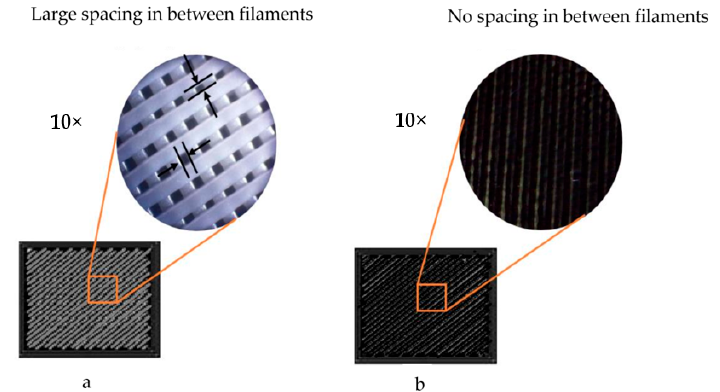
Figure 3. Internal structure of ( a ) density infill 70%, ( b ) density infill 100%.